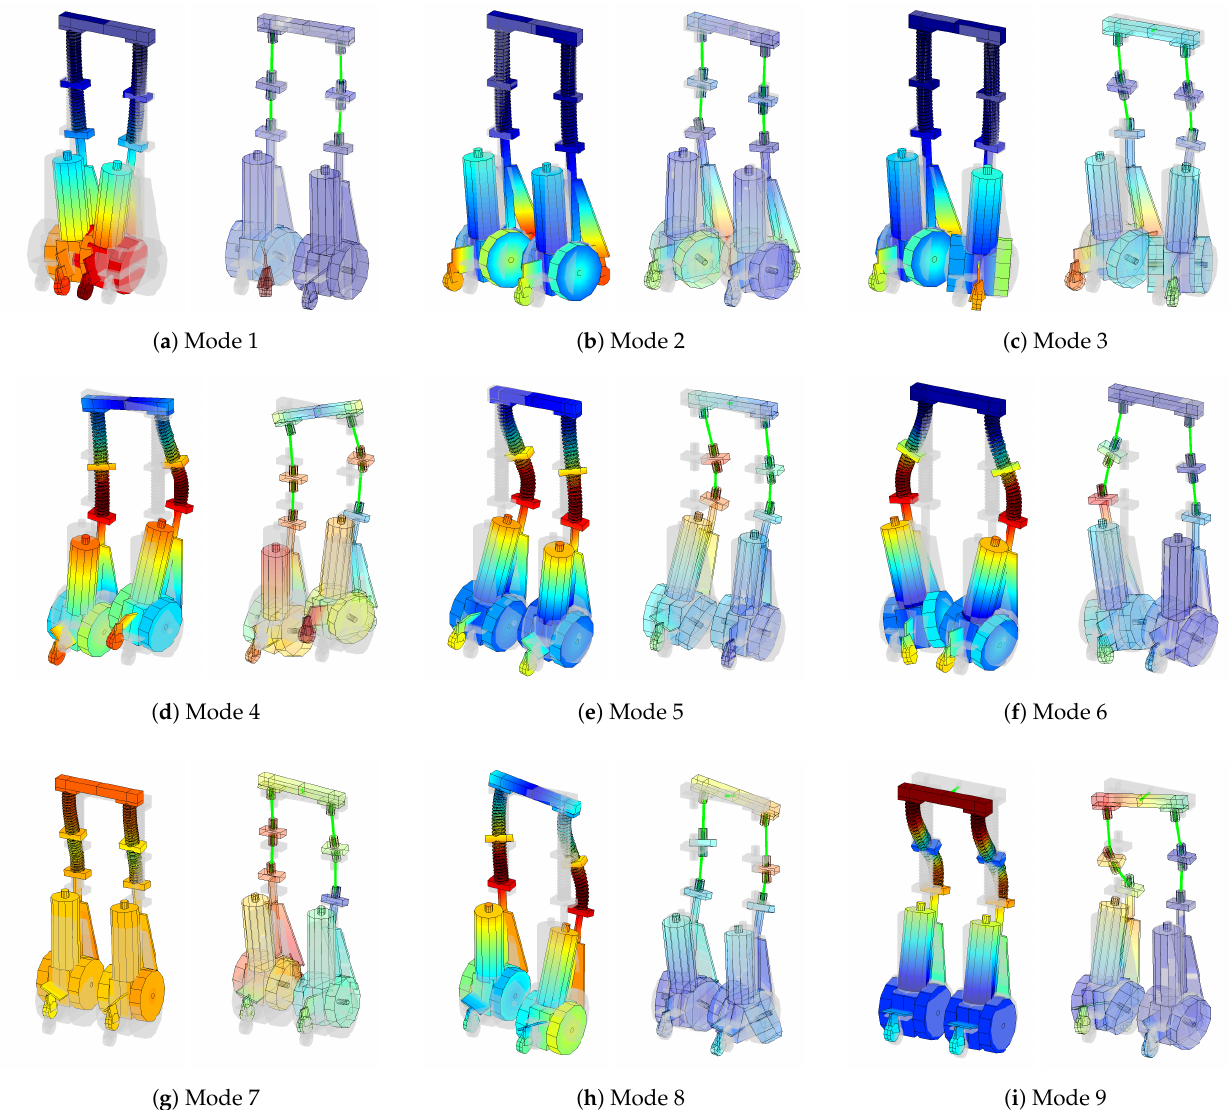
Figure 3. Robot mode shapes: numerical ( left , solid colours) and experimental ( right , transparent